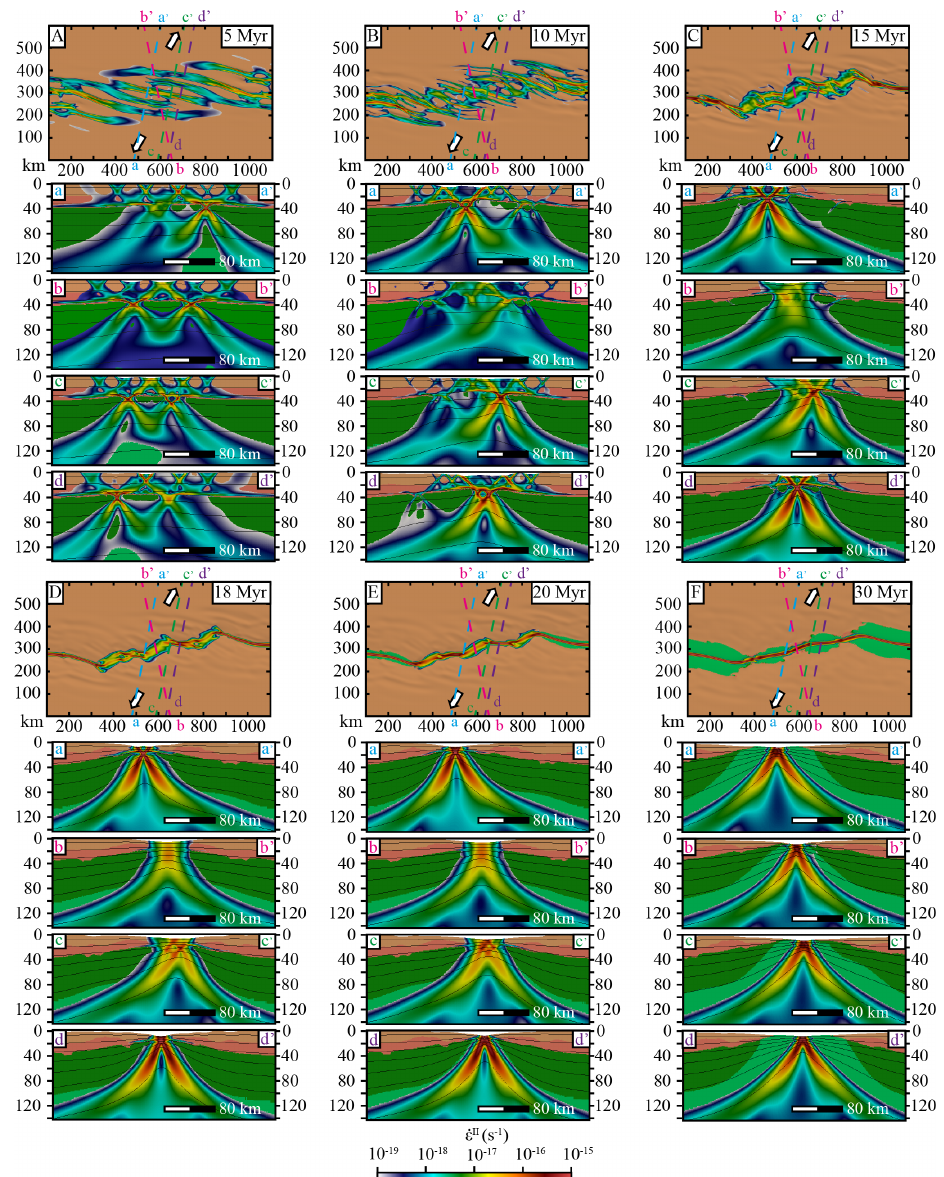
Figure 4. Model 1, weak lower crust, α = 60 ◦ . Map views and cross sections of simulated lithologies and second invariant of the strain rate tensor (Eq.